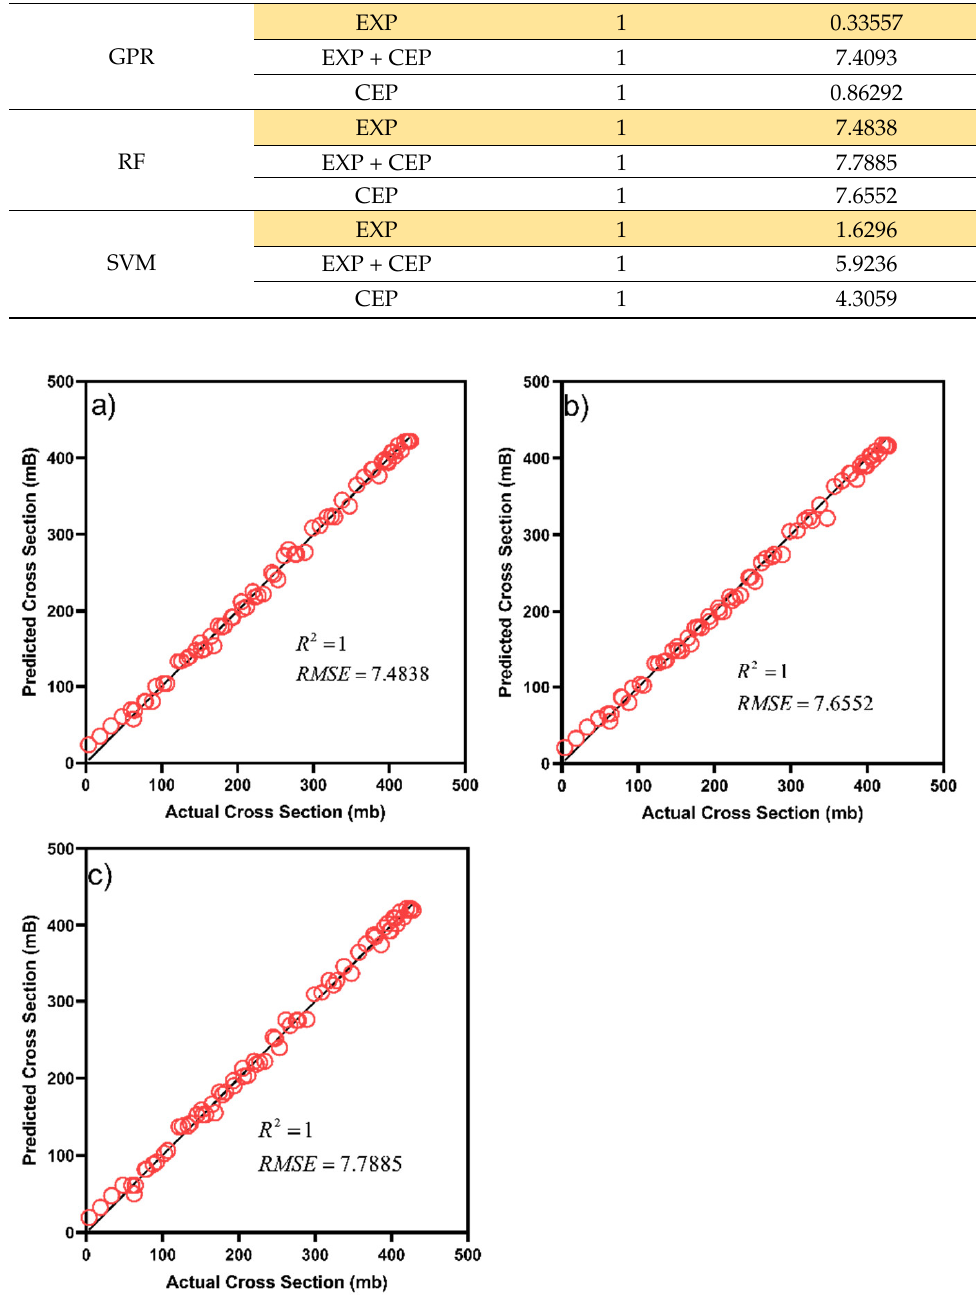
Figure 3. Graph of prediction vs. measured nuclear cross-section of 92 Mo ( n ,2 N ) 91 Mo for RF machine learning algorithm. The black line is the ENDF/B-VIII.0 library data while the red dot is the predictions done by the RF algorithms with ( a ) EXP, ( b ) CEP and ( c ) EXP + CEP as input.